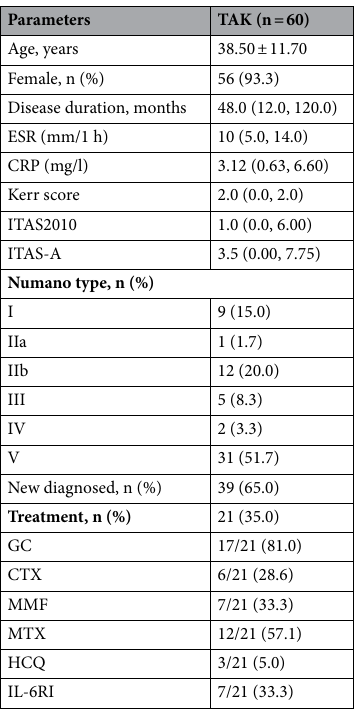
Table 1. Clinical characteristic of TAK patients. ESR erythrocyte sedimentation rate, CRP C-reactive protein, GC glucocorticoid, CTX cyclophosphamide, MTX methotrexate, MMF mycophenolate mofetil, HCQ hydroxychloroquine.